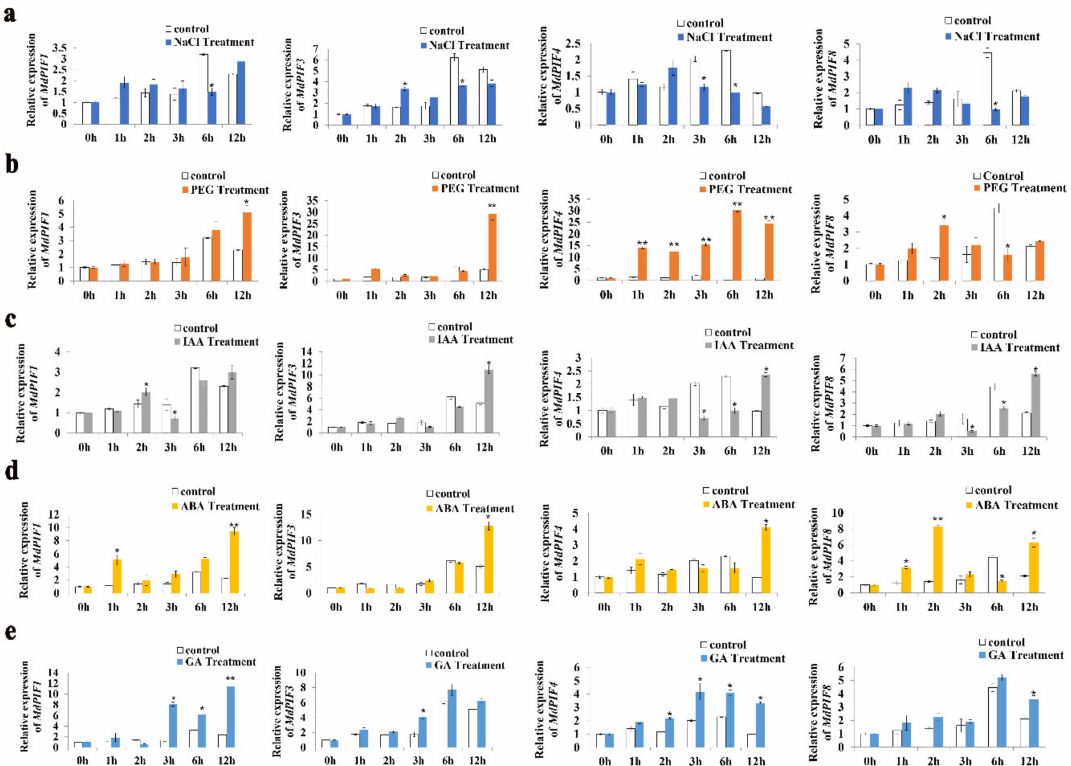
Figure 6. Expression analysis of MdPIF genes in response to abiotic stressors and hormones. Expression levels of the MdPIFs in response to NaCl ( a ), PEG 6000 ( b ), indole-3-acetic acid (IAA) ( c ), ABA ( d ) , and GA ( e ). Data are mean ± SD of three independent replicates. Asterisks denote significant di ff erences from control (*, p < 0.05; **, p <